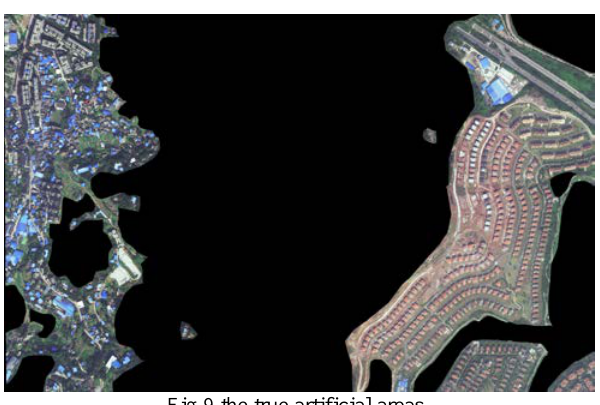
Fig.9 the true artificial